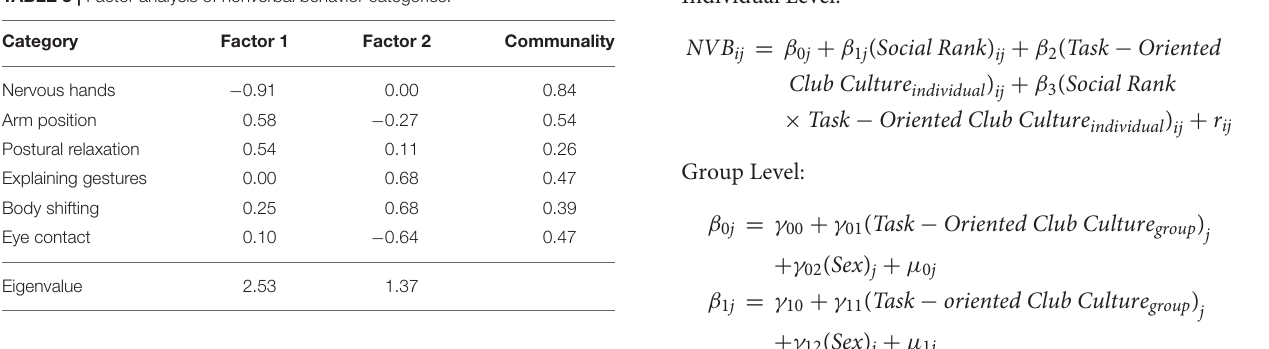
TABLE 3 | Factor analysis of nonverbal behavior